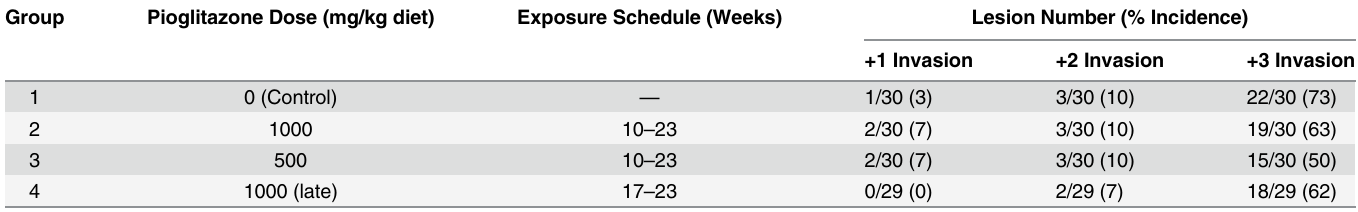
Table 5. Influence of Pioglitazone on Oral Cancer Invasion Score in NQO-treated F344 Rats. Group Pioglitazone Dose (mg/kg